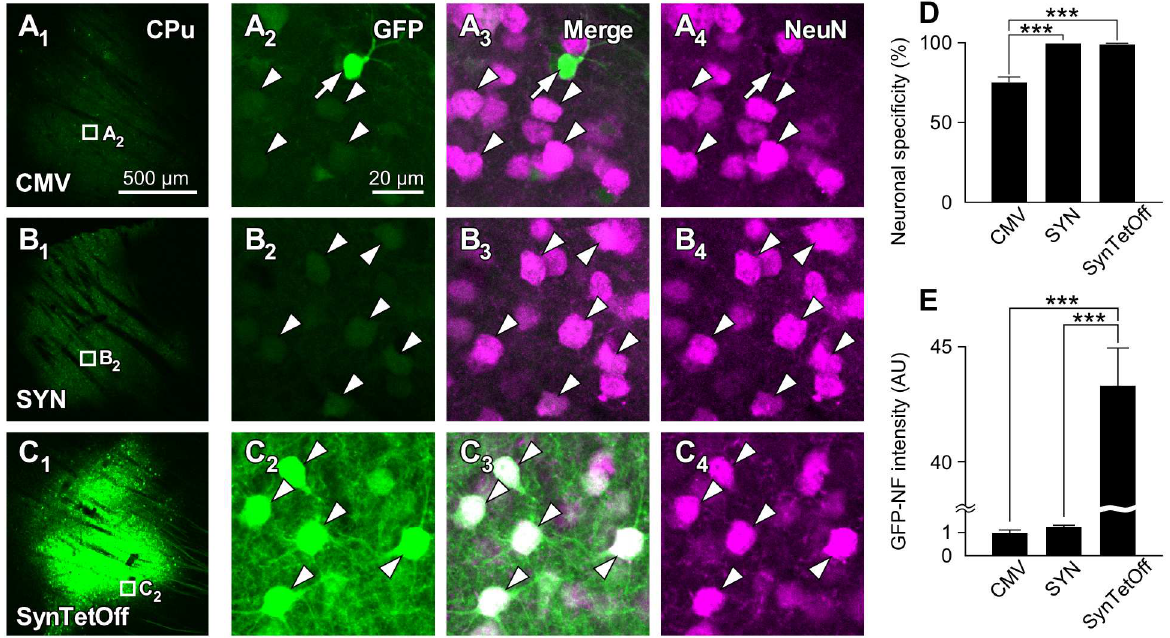
Fig 2. Neuron-specific and high-level transgene expressionwith the AAV-SynTetOff-GFP vector in vivo . ( A 1 –C 4 ) One week after the injectionof the AAV vectors, GFP-NF was observed in the caudate-putamen (CPu). Cells infected with the vector AAV2/ 1-SynTetOff-GFP (C) were more strongly labeledwith GFP than those infected with the vectors AAV2/1-CMV-GFP-BGHpA (A) and AAV2/1-SYN-GFP-BGHpA (B). Almost all GFP-positive cells were also immunoreactive for NeuNwith AAV2/1-SYN-GFP-BGHpA (B 2 –B 4 , arrowheads) and AAV2/1-SynTetOff-GFP (C 2 –C 4 , arrowheads),whereassome GFP-positive cells were negativefor NeuNwith the AAV2/1-CMV-GFP-BGHpA vector (A 2 –A 4 , arrow; a putative glial cell). Scale bar in A 1 appliesto A 1 –C 1 ; Scale bar in A 2 appliesto A 2 –A 4 , B 2 –B 4 , and C 2 –C 4 . ( D ) Specificitiesof GFP expressionin neostriatalneurons. AAV2/1-SYN-GFP-BGHpA and AAV2/ 1-SynTetOff-GFP displayedspecific expression in neuronal cells, whilethe expressionof GFP with AAV2/1-CMV-GFP-BGHpA was not neuron-specific. ( E ) GFP-NF intensities in neostriatal neurons. The mean GFP-NF intensity with AAV2/1-CMV-GFP-BGHpA was standardized as 1 AU. AAV2/1-SynTetOff-GFP transduced much strongerGFP expression in neuronsthan AAV2/1-CMV-GFP-BGHpA and AAV2/1-SYN-GFP-BGHpA (factors of 43.3 and 34.3, respectively). Error bars, ± SEM. * p < 0.05, ** p < 0.01, *** p < 0.001.